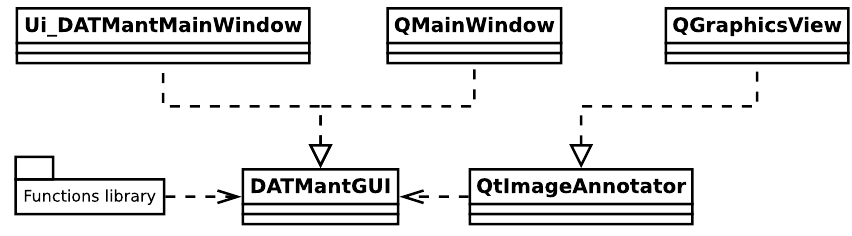
Figure 11. Simplified UML diagram of the class and package relationships making up the DATM annotation